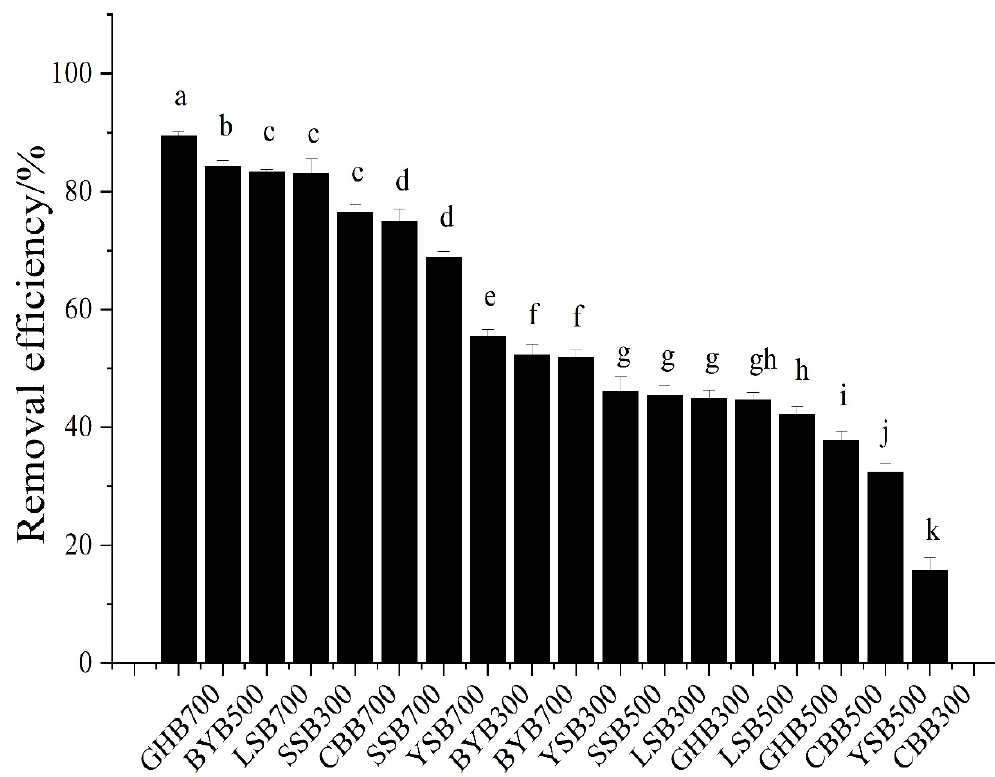
Figure 2. Comparison of different biochar removal efficiencies (initial Cr (VI) concentration: 50 mg·L − 1 ; dosage of biochar: 1.2 g·L − 1 ; pH: 2), different letters show significant differences at α = 0.05.